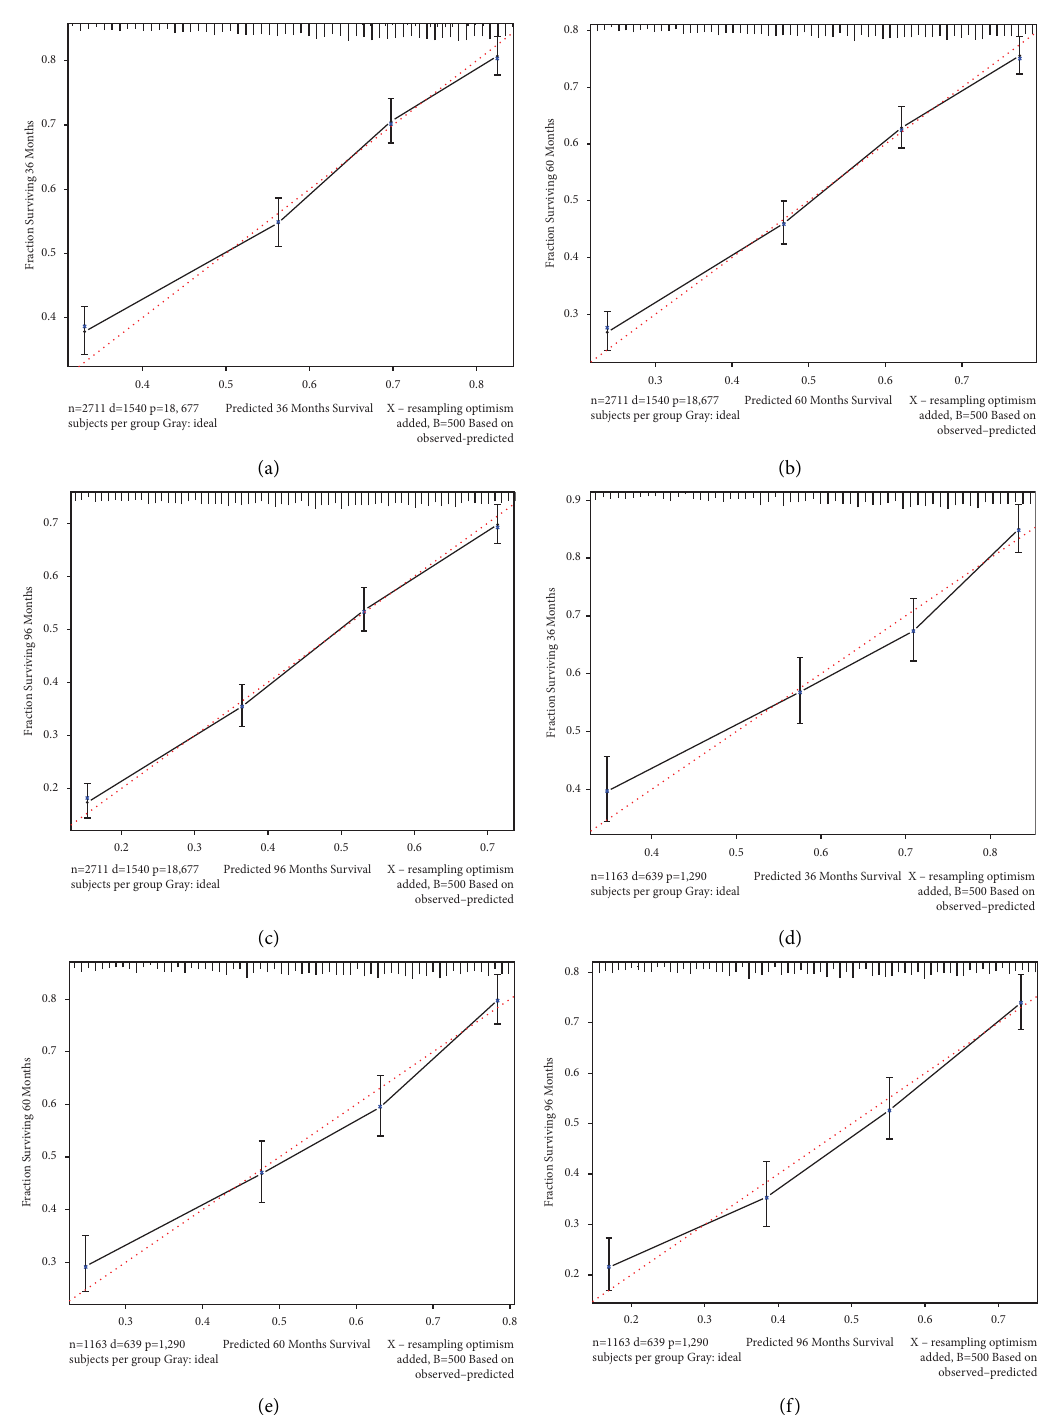
Figure 4: Calibration curves for the new nomogram. Both the t training cohort (a–c) and validation cohort (d–f) show that the calibration curves of the new nomogram are very close to the standard curve, and the points on the curve are evenly